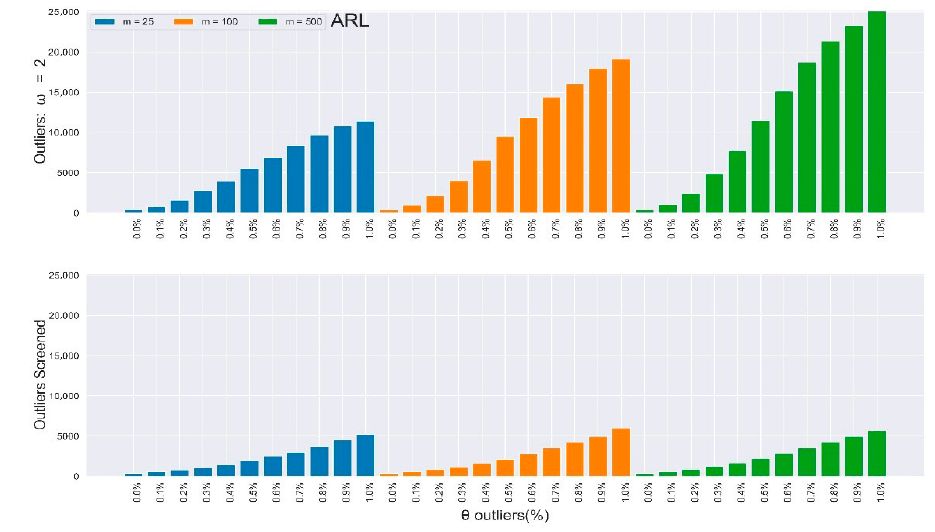
Figure 4. In-control ARL values of the multivariate Shewhart chart from a mixed distribution with and without SDRE multivariate outliers screening ( ω = 2).